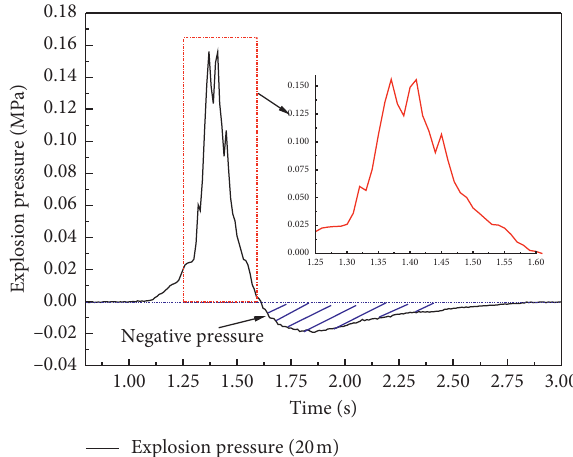
Figure 7: The explosion pressure-time curve at 20m from the point of ignition.